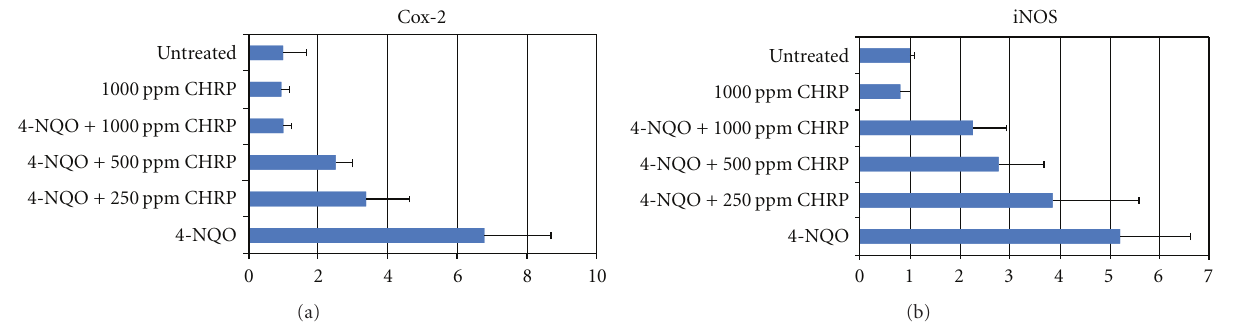
Figure 8: Dietary CHRP suppresses mRNA expression of inflammatory enzymes, Cox-2 and iNOS, in the tongue of rats that received 4-NQO at week 8 of the study.